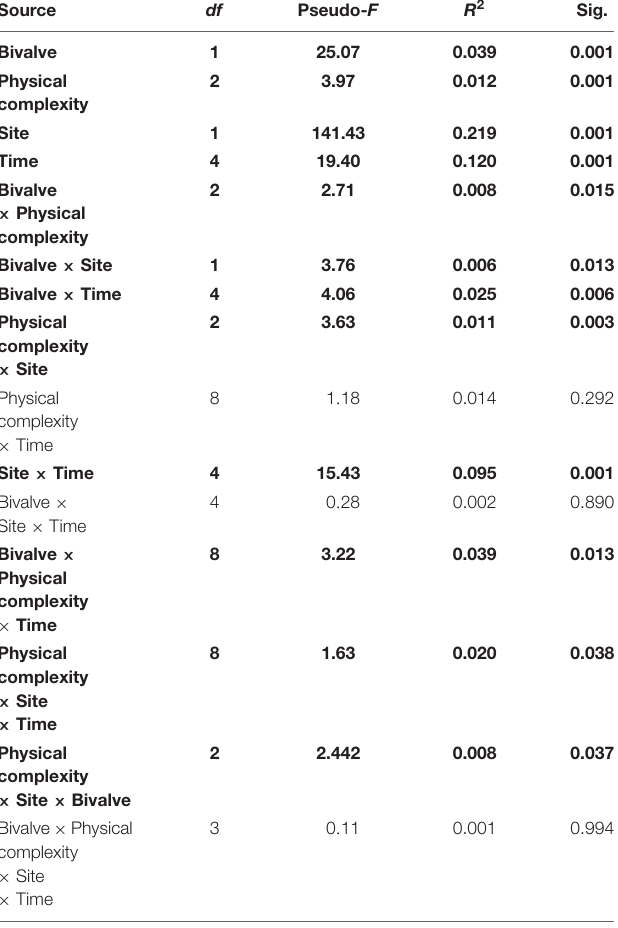
TABLE 4 | PERMANOVA testing the effect of physical complexity, number of live seeded bivalves, and time on the colonising sessile assemblages at two sites. Source df Pseudo- F R 2